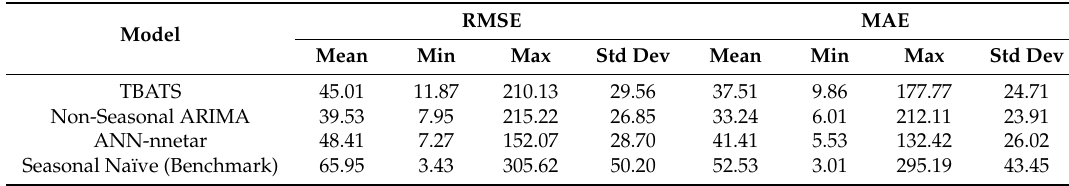
Table 3. Statistical comparison of